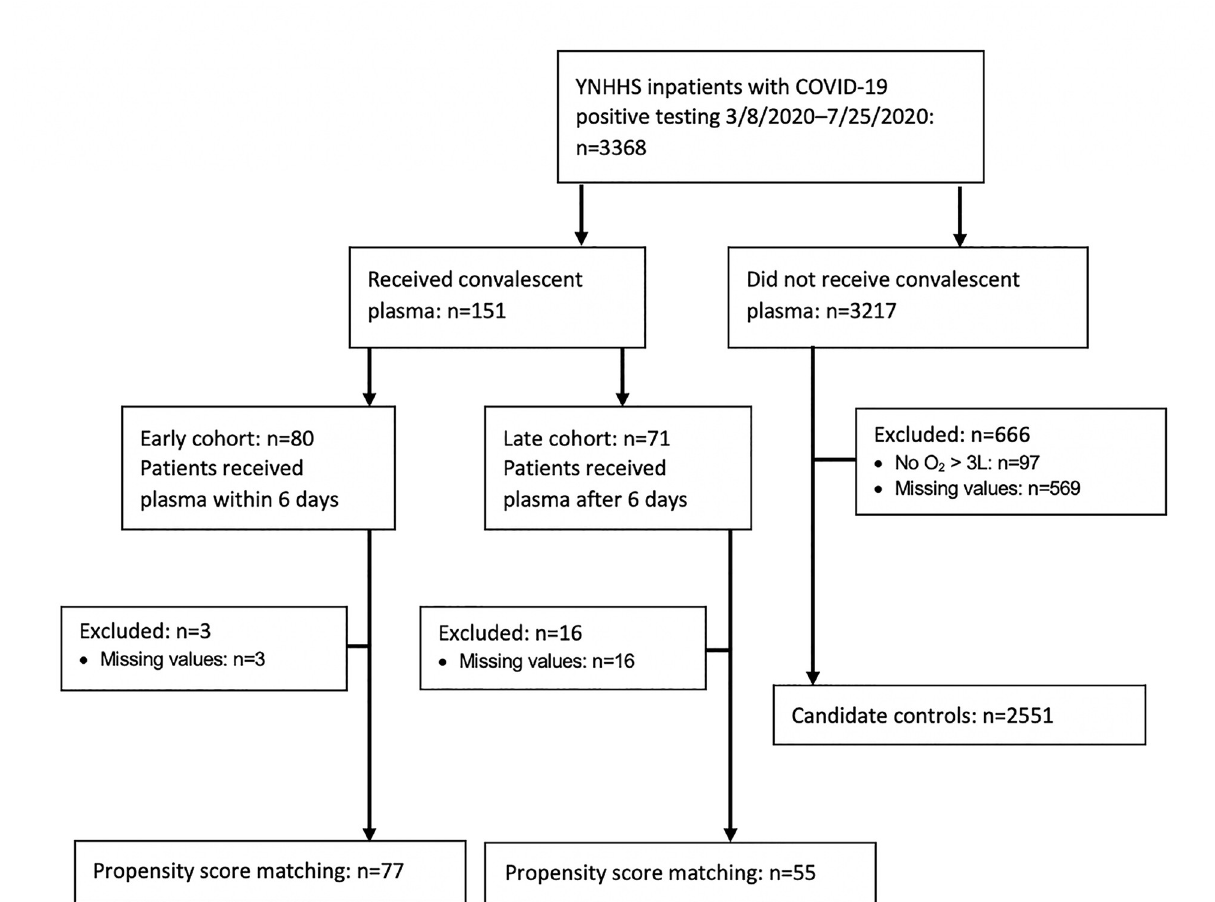
Fig 1. Consort selection tree. Patient disposition in the observational cohort analysis.